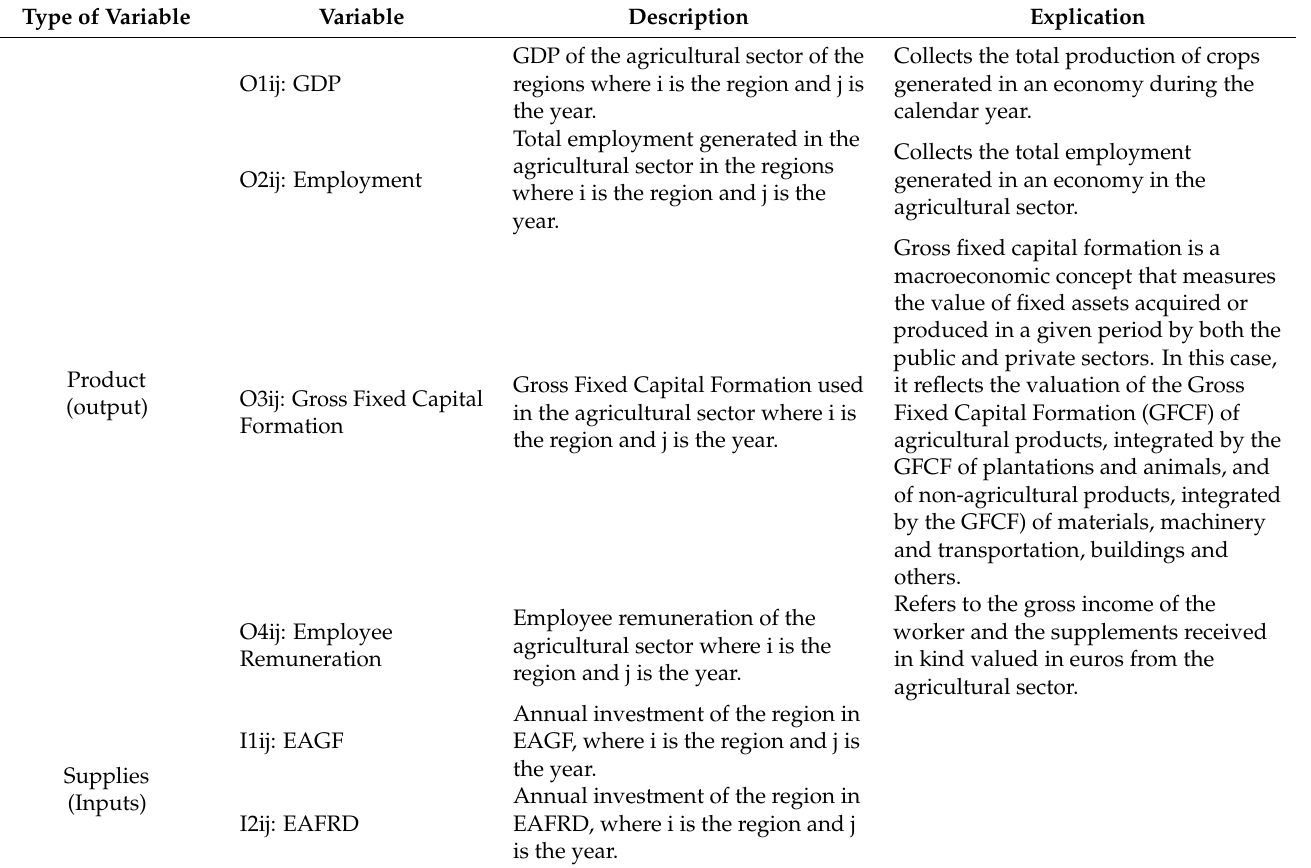
Table 3. Production function of the degree of efficiency in the use of agricultural funds (Source: Own elaboration). Type of